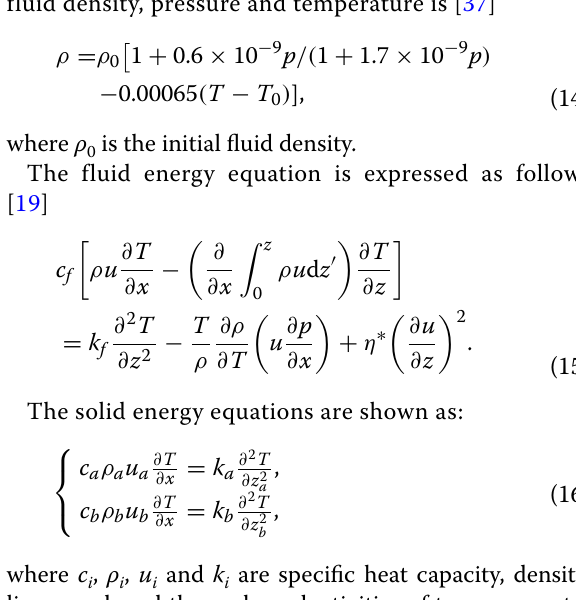
Figure 6 Oil film stiffness models of double involute